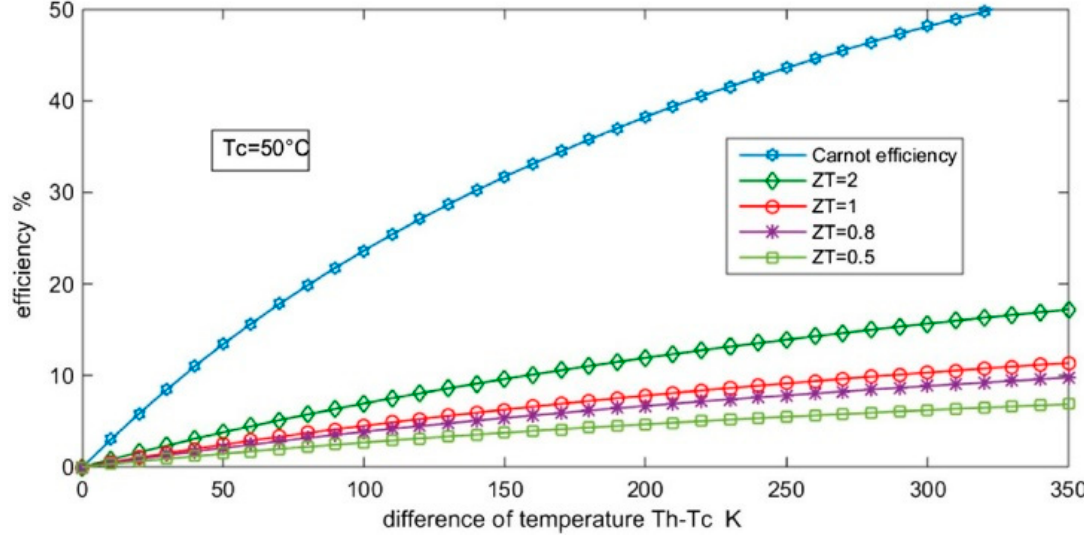
Figure 1. ( a ) Working principle of TEG and TEC; ( b ) components of a typical thermoelectric generator.